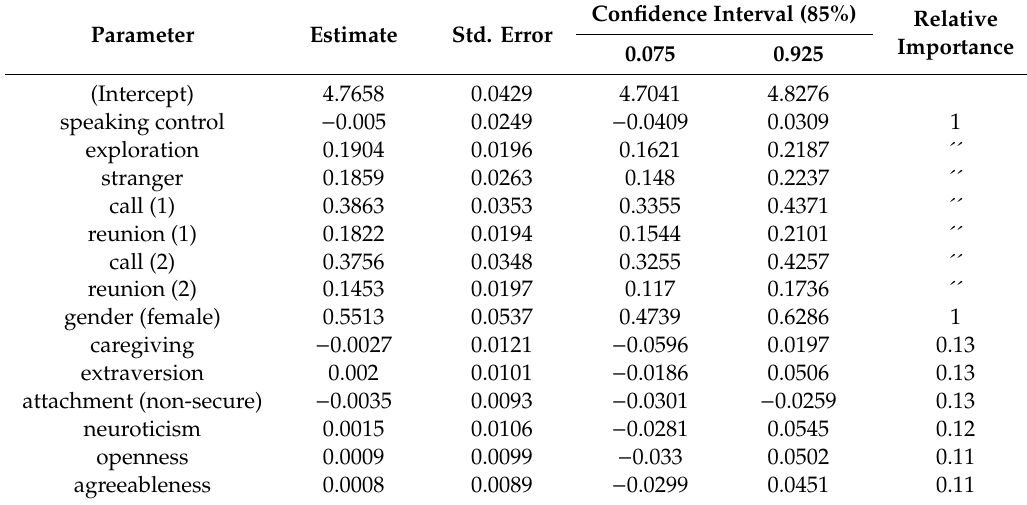
Table 1. Model averaged coe ffi cients for mean pitch models. Only variables with a minimum relative importance of 1 and a confidence interval not ranging over 0 are taken into consideration for model interpretation.